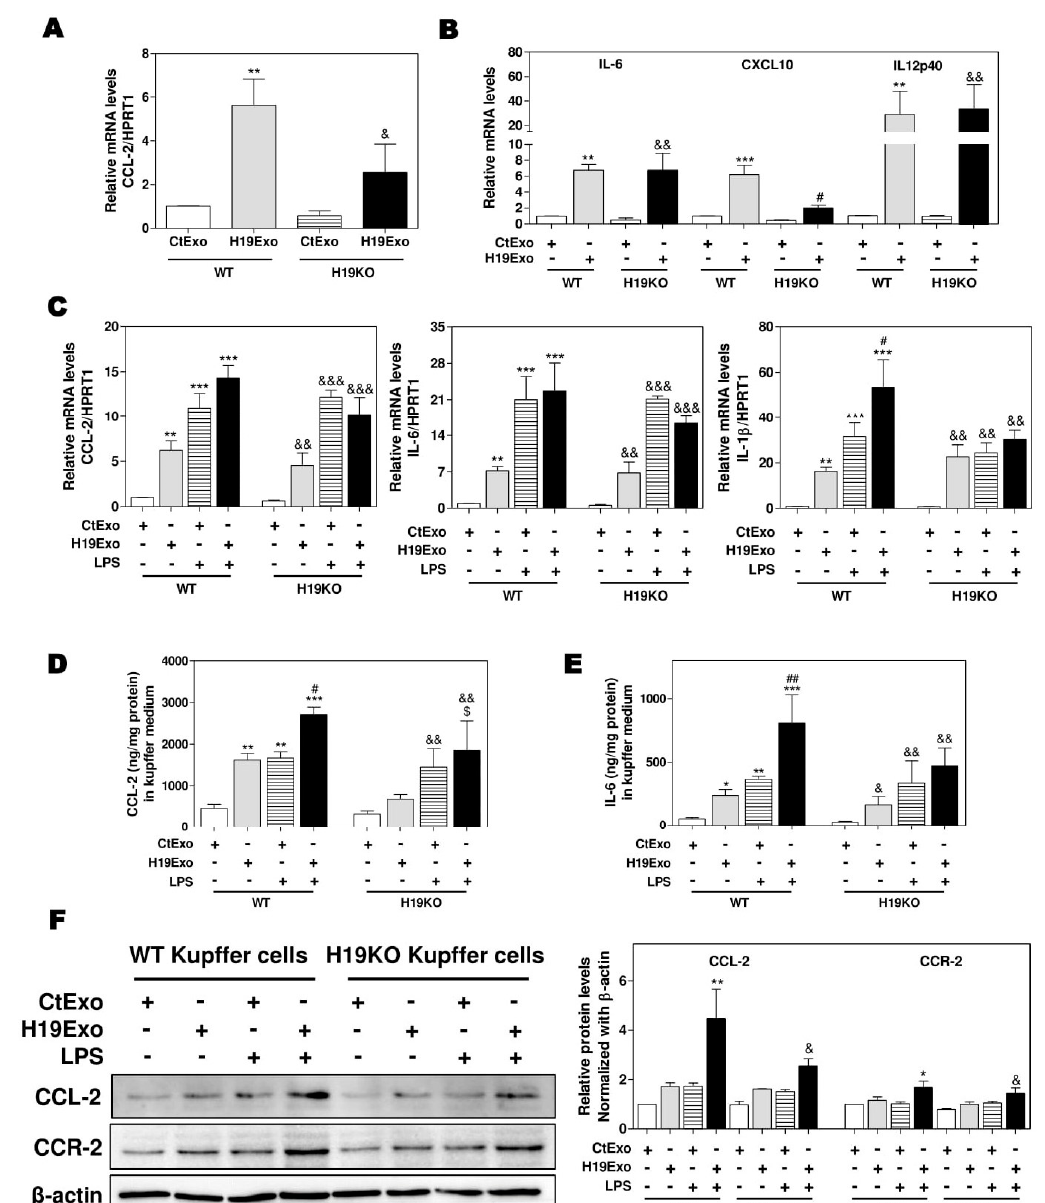
Figure 1. Cholangiocyte-derived exosomal H19 promotes Kup ff er activation. ( A , B ) Mouse Kup ff er cells were treated with control mouse large cholangiocytes (MLE)-derived exosomes (CtExo) and H19-overexpressing MLE-derived exosomes (H19Exo) for 24 h. ( A , B ) The relative mRNA levels of chemokine (C-C motif) ligand 2 (CCL-2), interleukin-6 (IL-6), chemokine (C-X-C motif) ligand 10 (CXCL10), and IL12p40 were measured by real-time RT-PCR and normalized using HPRT1 (Hypoxanthine-guanine phosphoribosyltransferase 1). ( C – F ) Mouse Kup ff er cells were treated with CtExo, H19Exo, and lipopolysaccharide (LPS) (10 ng / mL) for 24 h. ( C ) The relative mRNA levels of CCL-2, IL-6, and IL-1 β were measured by real-time RT-PCR and normalized using HPRT1. ( D , E ) The protein levels of CCL-2 and IL-6 in the conditioned medium of Kup ff er cells were measured by ELISA assay and normalized using protein concentration. ( F ) Representative immune blot images of CCL-2 and CCR-2 are shown. Relative protein levels were normalized using β -actin. Results from at least three independent experiments are presented as Mean ± SEM. Statistical significance: * p < 0.05, ** p < 0.01, *** p < 0.001, compared with WT control group; # p < 0.05, ## p < 0.01, compared with WT H19Exo group; & p < 0.05, && p < 0.01, &&& p < 0.001, compared with H19KO control group; $ p < 0.05, compared with H19KO H19Exo